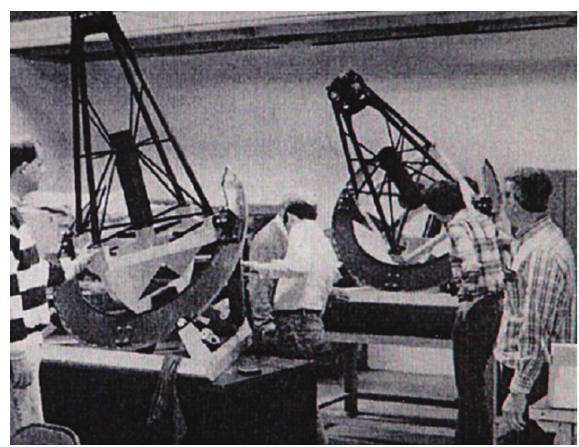
Figure 5: Early APT